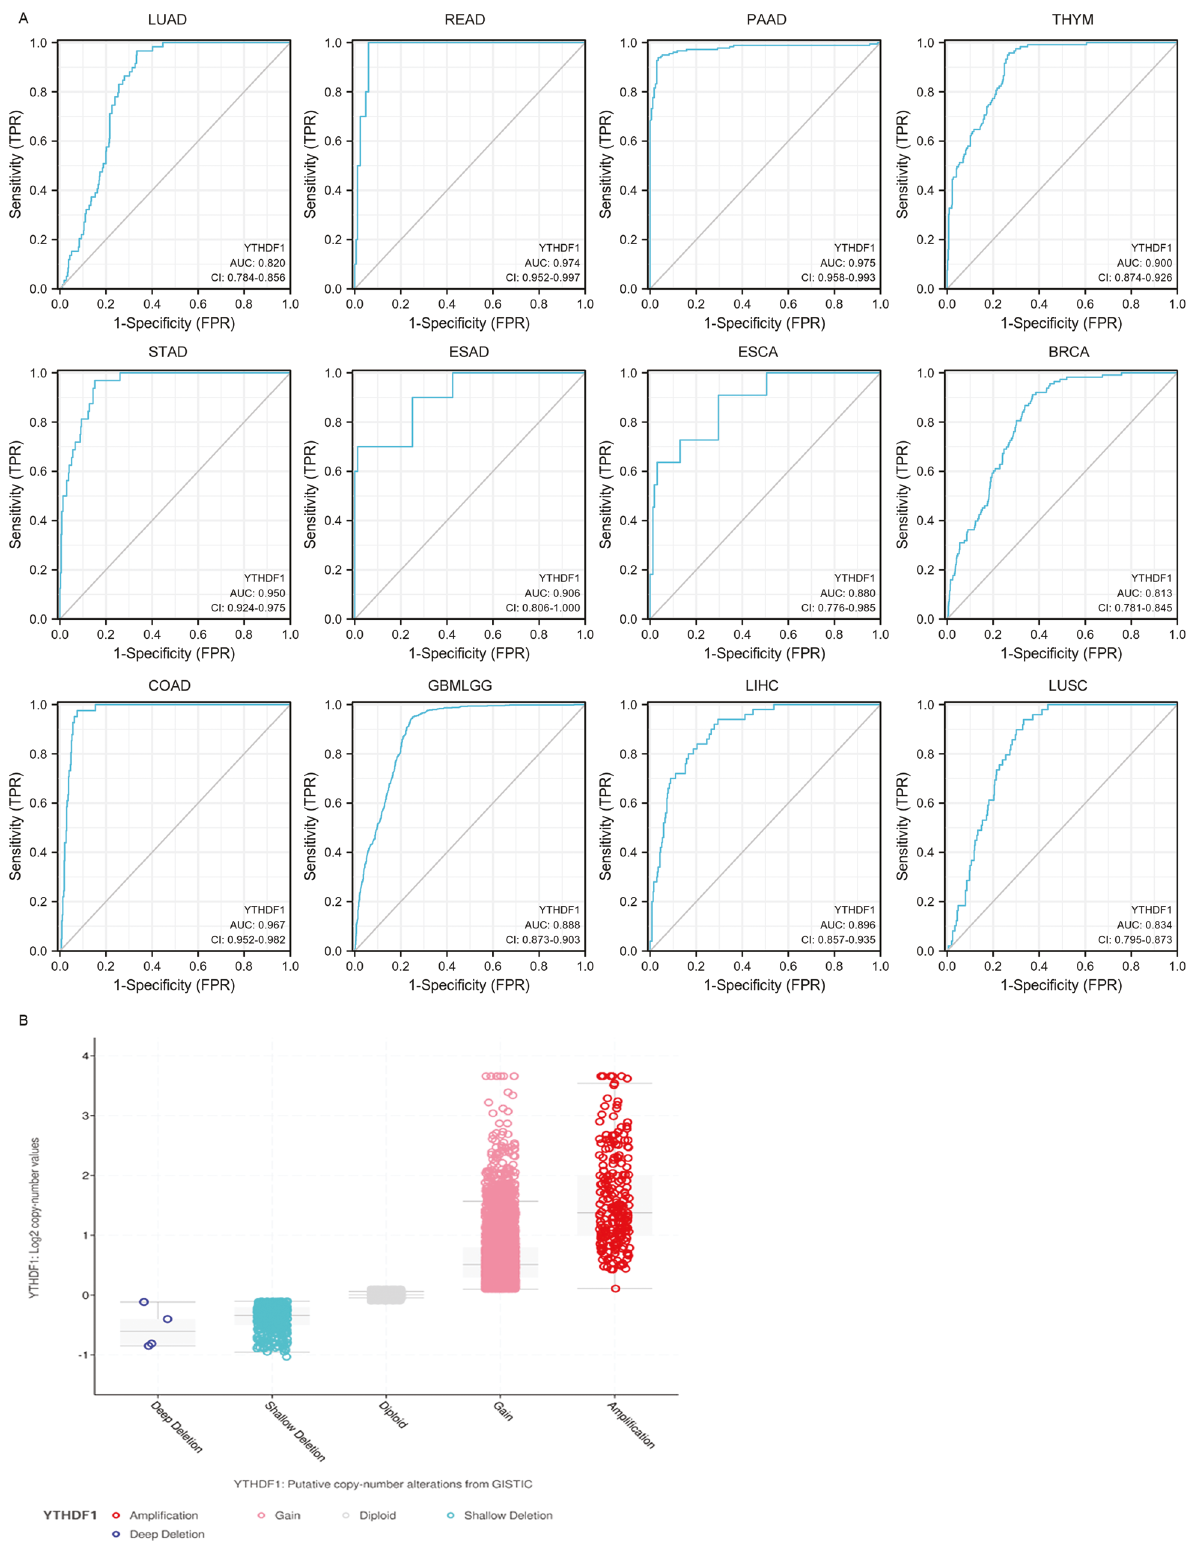
Fig. 2 The diagnostic value of YTHDF1 in human cancers. A YTHDF1 was potentially used as the biomarker for early diagnosis with high speci fi city and sensitivity in various human cancers. LUAD, READ, PAAD, THYM, STAD, ESAD, ESCA, BRCA, COAD, GBMLGG, LIHC, and LUSC. B DNA copy number ampli fi cation of YTHDF1 in 10712 samples from 32 studies with various cancers based on cBioPortal